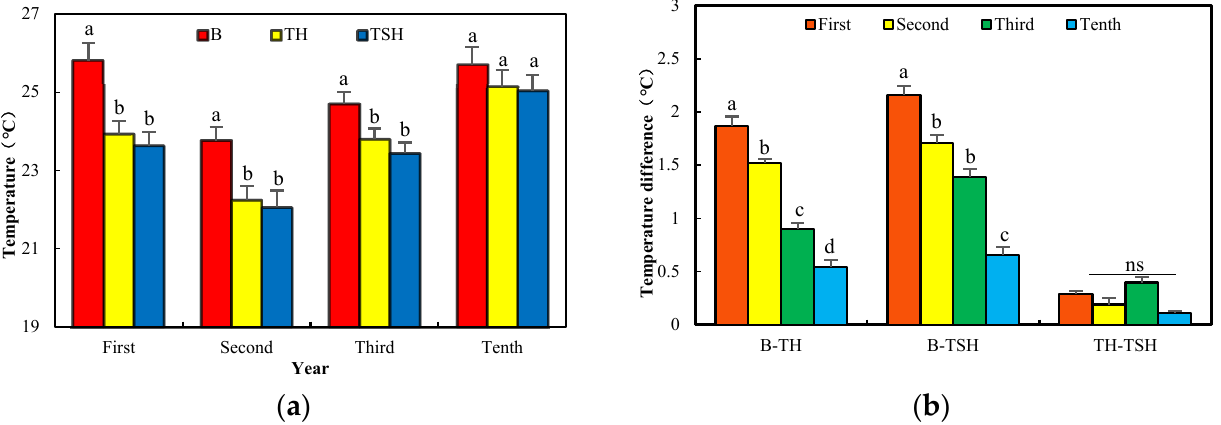
Figure 4. ( a ) Average temperature of different vegetation type combinations in different restoration years; ( b ) Temperature differences of different vegetation type combinations in different restoration years. ns: there is no significant difference for temperature among different restoration years. (a–d): the different letters indicate that there is a significant difference between two vegetation type combinations ( p < 0.05).